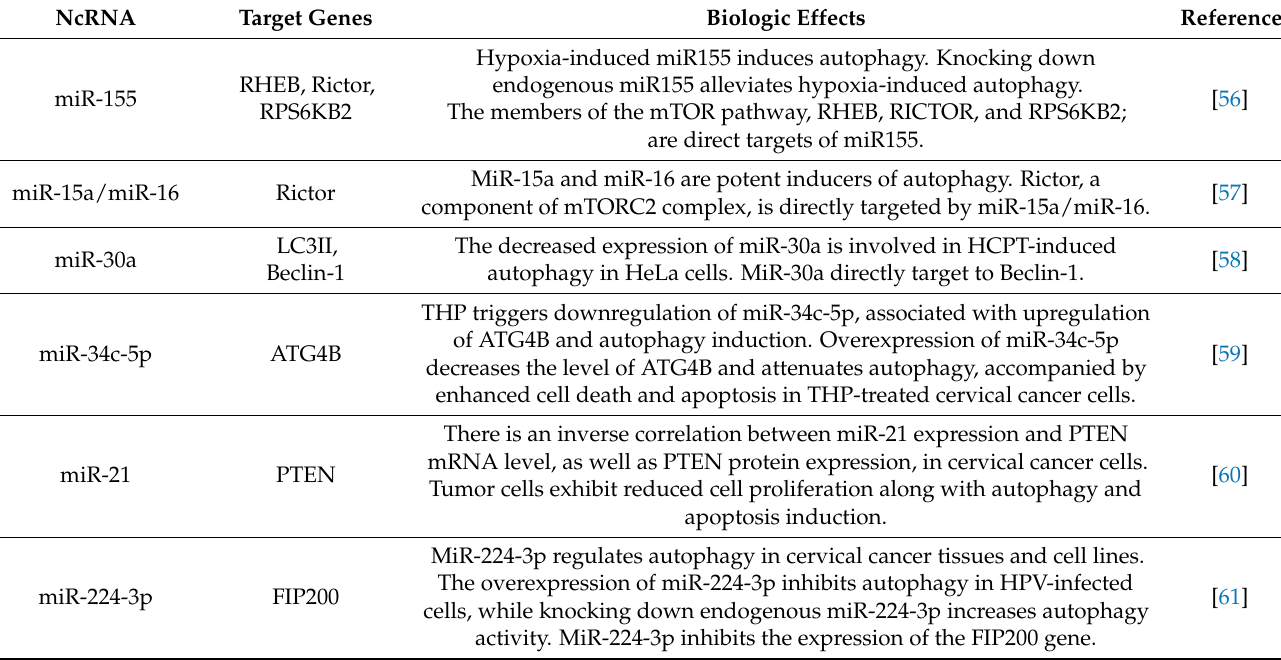
Table 1. ncRNAs involved in the autophagy process in cervical